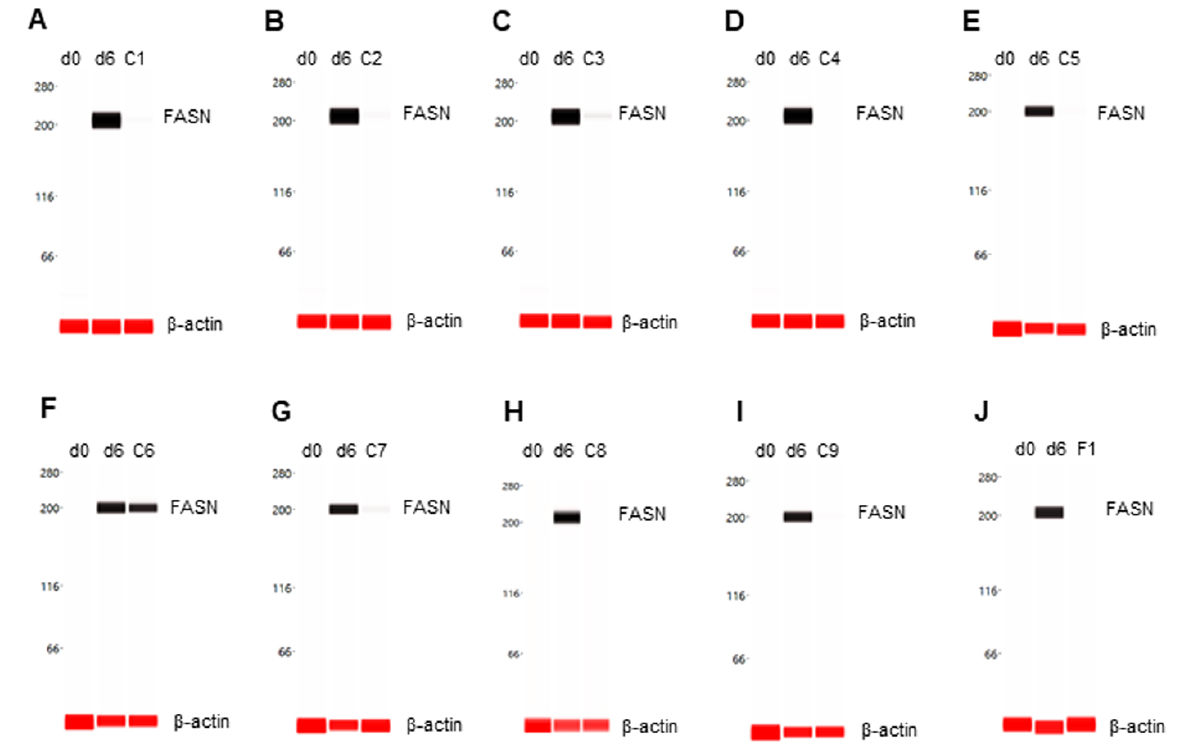
Figure 3. Suppression of FASN expression in differentiating preadipocytes. Expression level of FASN in preadipocytes on d0, d6 post-differentiation, or d6 post-differentiation in the presence of ( A ) berberine (C1), ( B ) luteolin (C2), ( C ) resveratrol (C3), ( D ) fisetin (C4), ( E ) quercetin (C5), ( F ) fu- coidan (C6), ( G ) EGCG (C7), ( H ) hesperidin (C8), ( I ) curcumin (C9), or ( J ) F1 composition . β -actin served as a loading control. The protein expression level was measured using multiplexed capillary Western immunoassays. Molecular markers in kilodalton (kDa) are displayed on the left of the ca- pillary Western immunoassay data.